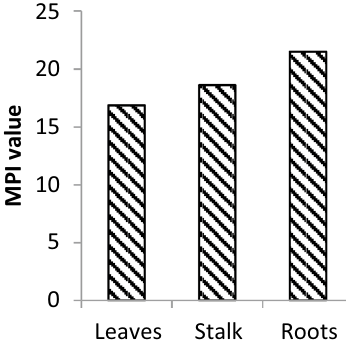
Figure 3. MPI values in E. crassipes .